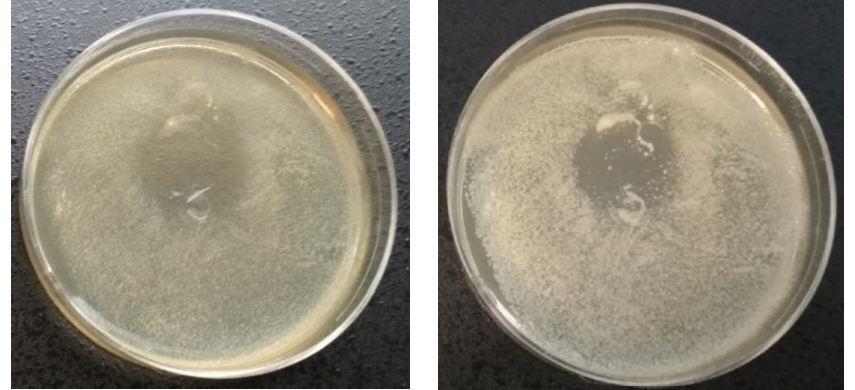
Figure 7. Inhibition zone observed after 24 h from the 5 min treatment of the undiluted culture using 9 W power ( left )and the regrowth of the peripheral regions of the zone after the 48 h cultivation ( right ).